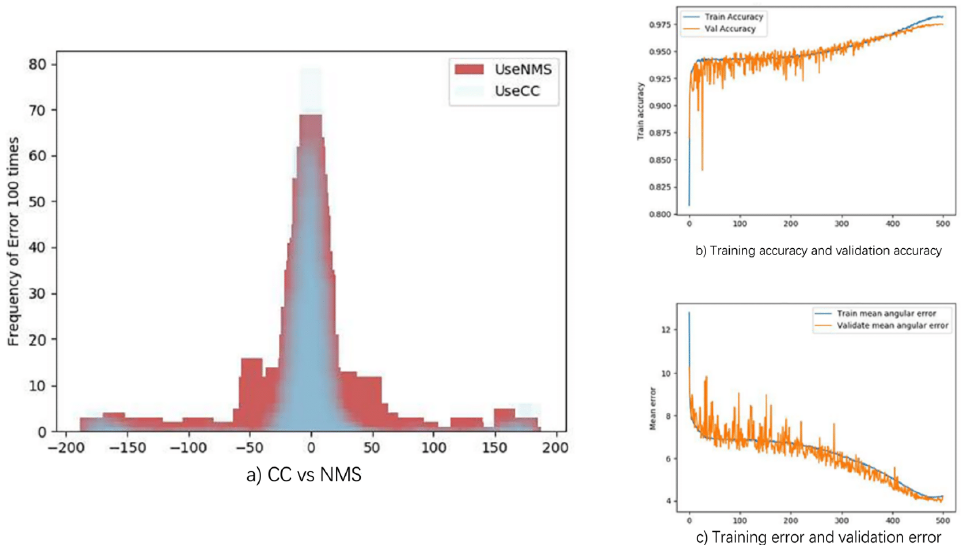
Figure 9. ( a ) The frequency of the angular detection error with CC and NMS; ( b ) the training accuracy and validation accuracy of SACN, converging at 97% with 500 epochs; and ( c ) the regressive average angular error, which is predicted by the third stage, converging at 4.5 ◦ with 500 epochs.